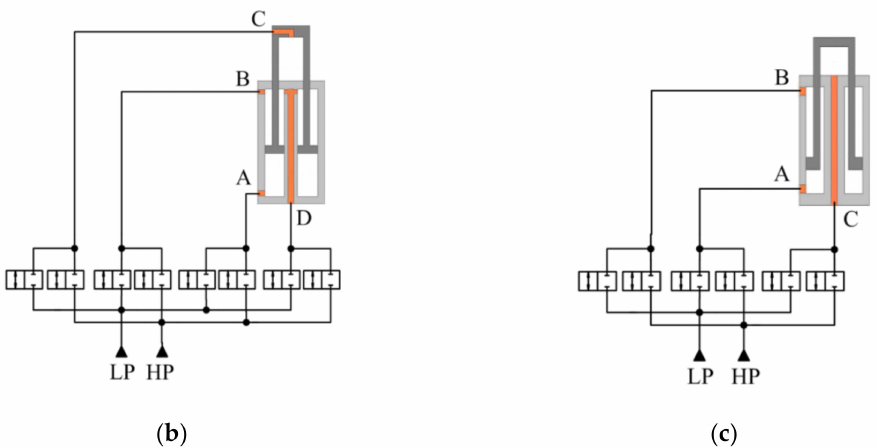
Figure 15. Parallel digital hydraulic cylinders: ( a ) multiple cylinder parallel connection mode; ( b ) parallel digital hydraulic cylinder with multiple piston cavities (1); ( c ) parallel digital hydraulic cylinder with multiple piston cavities